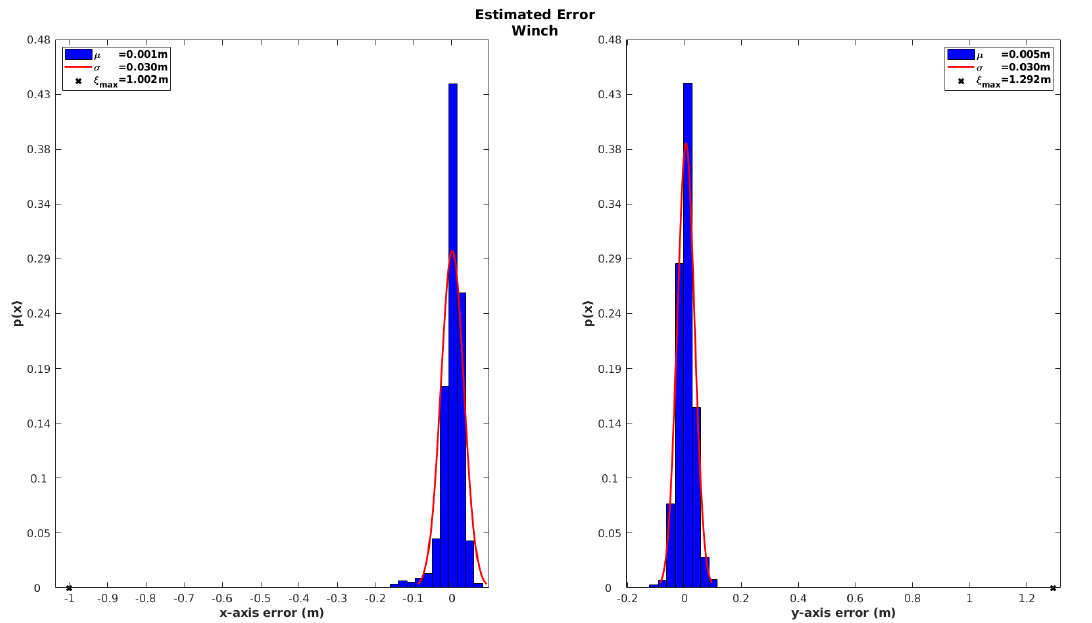
Figure 15. Absolute position error for the USBL model characterized in terms of the innovation of the winch